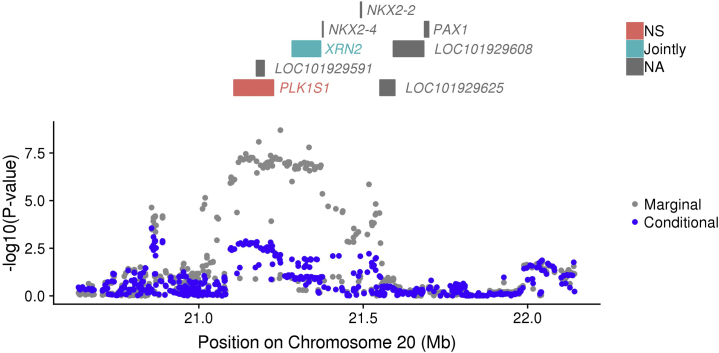
Regional association plot. The top panel shows all of the protein-coding genes or genes in the transcriptome-wide association study. Jointly significant genes are highlighted in blue, nonsignificant (NS) genes are highlighted in red, and genes that were not in the transcriptome-wide association study (NA) are in gray. The bottom panel shows a Manhattan plot of the genome-wide association study data before (gray) and after (blue) conditioning on the jointly significant genes.